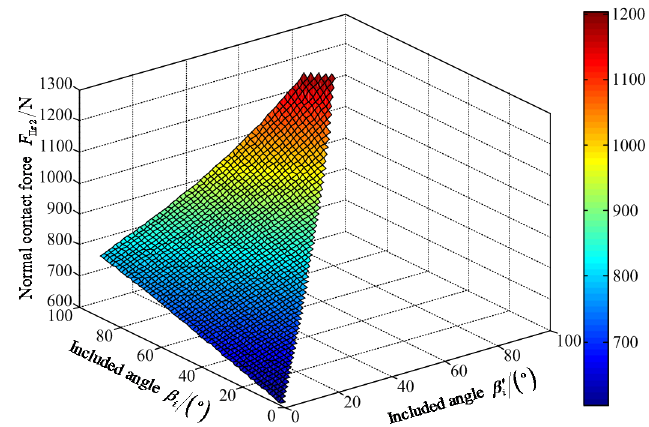
Figure 12. Variable tendency chart of normal contact force F II z 2 with the changes of β i ′ and β i .